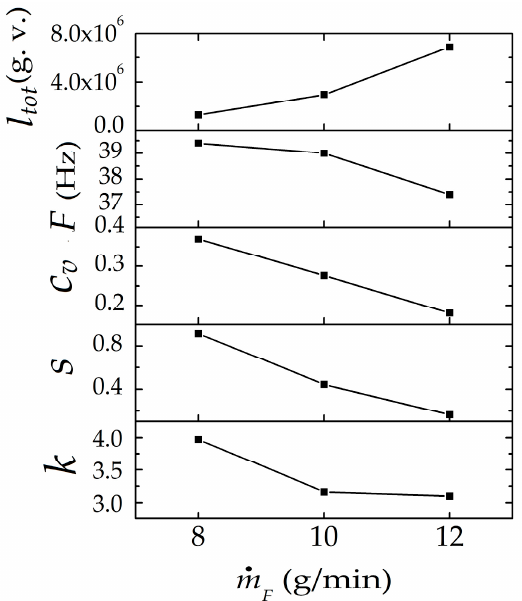
Figure 10. Flickering parameters of total luminosity for fuel mass flow rate. With respect to the skewness s and kurtosis k , the s linearly reduced as . m F . The values of s for all cases are larger than 0, which means the had a decreasing trend with